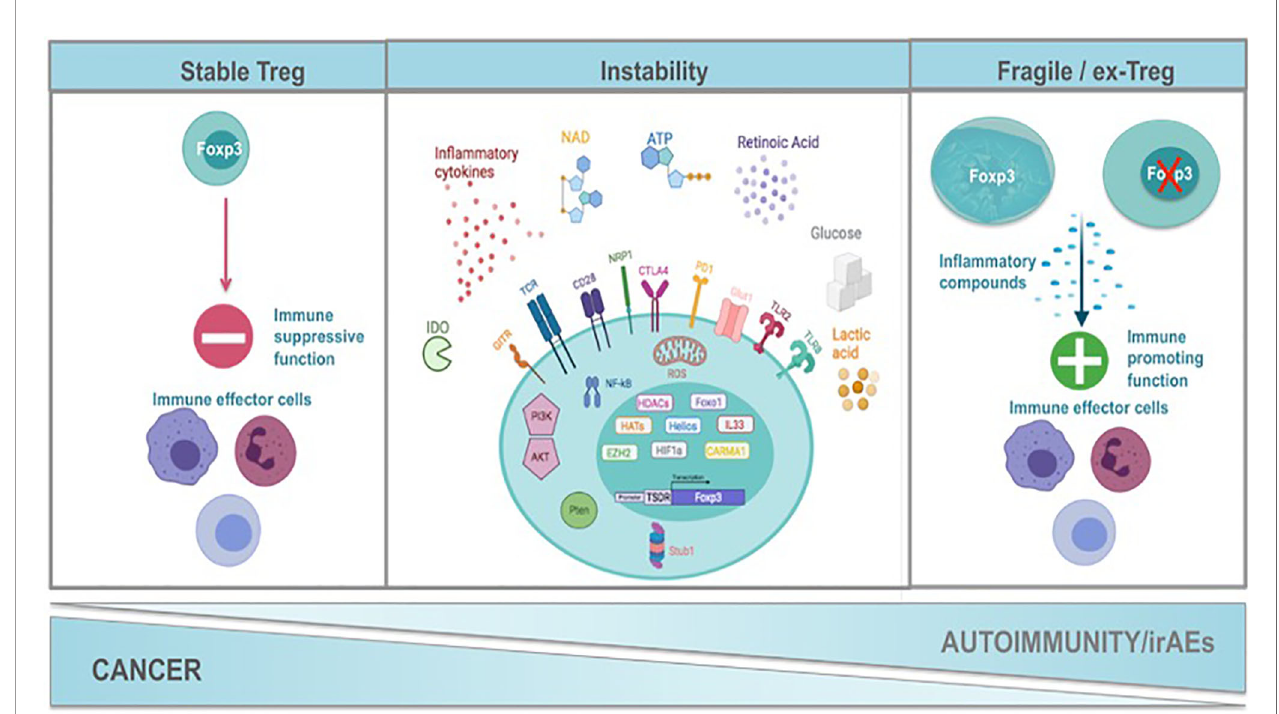
FIGURE 1 | Mechanisms of Treg functional instability constrain cancer while promote autoimmunity and the development of immune related adverse events after immunotherapy. Treg cells exert a strategic role in the maintenance of immune homeostasis. Foxp3 is the hallmark transcription factor of Treg cells orchestrating their function. A complex network of transcription factors such as HELIOS, HIF1a and Foxo1, transcription regulators such as IL33, histone deacetylases, histone methylotransferases, signalosome proteins (CARMA) maintain the transcriptional identity of Tregs and contribute signi fi cantly Treg cell stability. Exposure of Tregs to in fl ammatory stimuli such as in fl ammatory cytokines (IL1b, IL6, IFN g , IFN b , IL12), NAD, ATP and Retinoic Acid results in the alteration of their transcriptional program, in the expression of transcription factors and cytokines that are characteristic of T helper cells and at the end in the attenuation of Treg suppressive function. This may be accompanied by the loss of Foxp3 expression and the generation of ex-Tregs or the generation of fragile Tregs that retain Foxp3 expression. The strength of TCR signaling together with costimulatory and coinhibitory molecules (CD28, GITR, NRP1, CTLA4, PD1) in fl uence downstream pathways such as PI3K/AKT, PTEN, NFkB and the production of ROS by the mitochondria that are critical nominators of the maintenance of Treg transcriptional program and Treg suppressive identity. Oxidative phosphorylation and fatty acid oxidation are metabolic hallmarks of Tregs suppressive function. Any perturbations in the metabolic program of Tregs result in their transformation into non suppressive fragile or ex-Tregs. In autoimmunity the presence of fragile/ex-Tregs burdens the in fl ammatory response while in cancer stability of Tregs supports the immunosuppressed tumor microenvironment. Immune-checkpoint immunotherapy (ICI) applied in cancer seems to be the destabilization of Tregs and their conversion to fragile or ex-Tregs that may cause the immune-related adverse events (irAEs). Created with